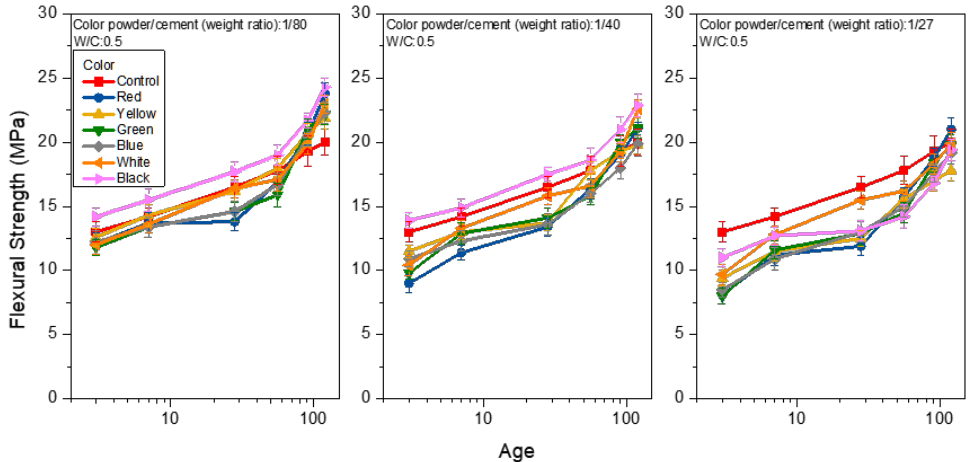
Figure 9. Flexural strength of colored mortar at W/C = 0.5 and under saturated limewater curing when weight ratios of color powder/cement at 1:80, 1:40, and 1:27 are added.